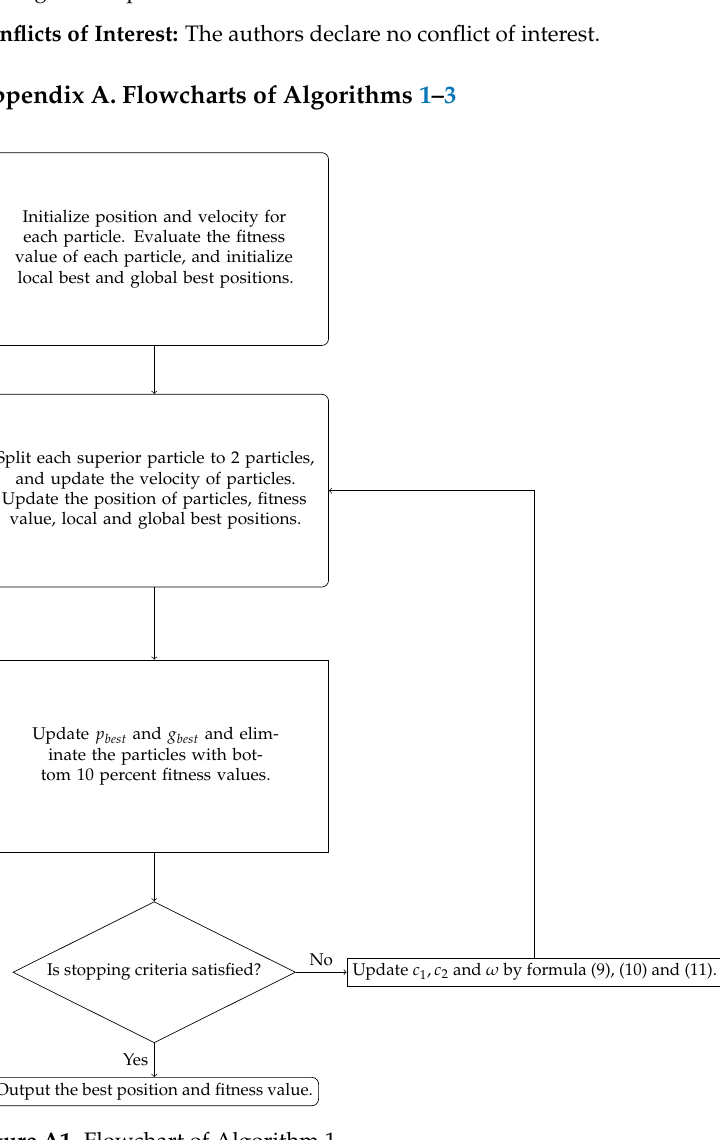
Figure A1. Flowchart of Algorithm